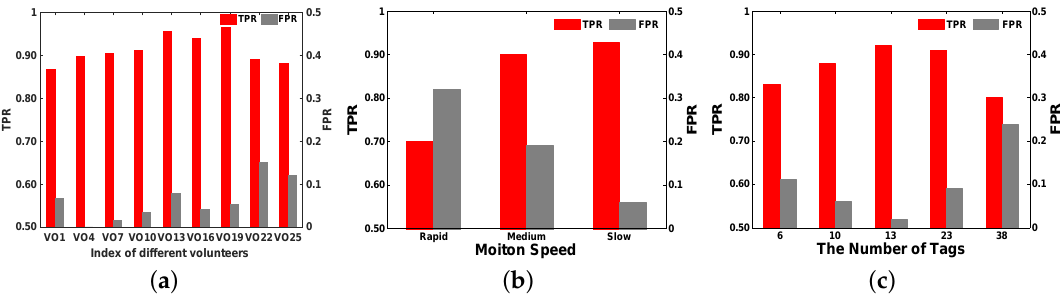
Figure 15. The comparison of TRP and FPR. ( a ) TPR and FPR under different volunteers; ( b ) TPR and FPR under different speeds; ( c ) TPR and FPR under different numbers of